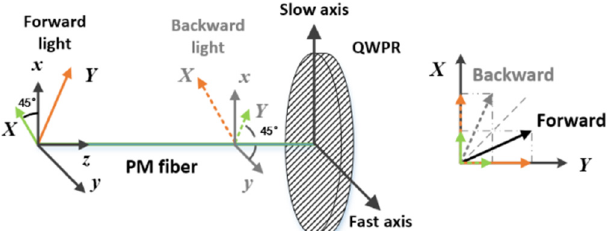
Figure 2. The forward light (or incident light) and backward light (or output light) after the reflection by a QWPR, where the angle between the direction of X -polarization state, and the slow axis of the QWP ( x -direction) is 45 degrees.